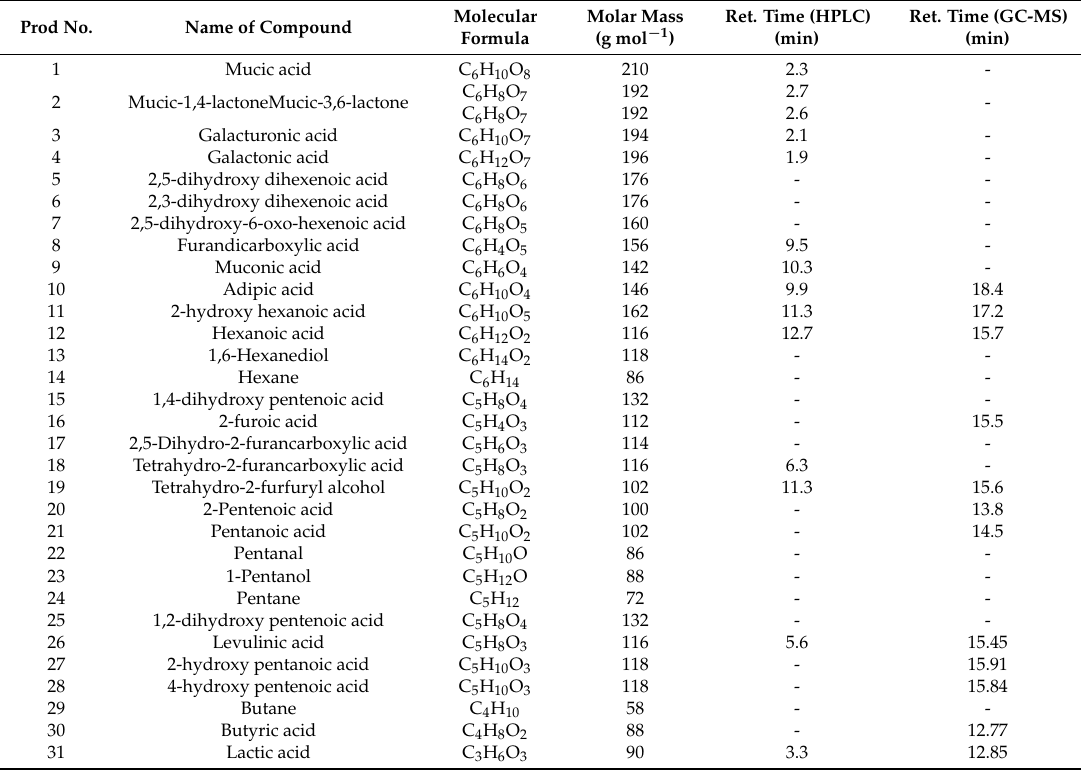
Table 2. List of compounds with molecular formula, molar mass, and retention times according to the HPLC and GC-MS analysis.